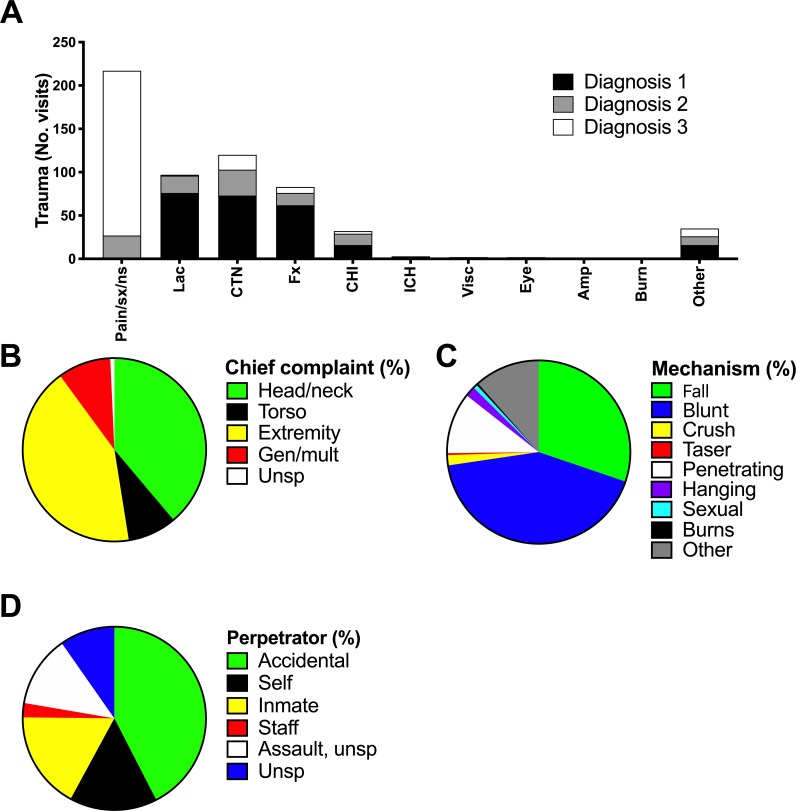
Incarcerated trauma patients present with a range of injuries and mechanisms.Primary, secondary, and tertiary discharge diagnoses (A), primary injury location (B), mechanism of injury (C), and reported perpetrator (D) for 278 trauma-related encounters of incarcerated patients presenting to a tertiary care, academic emergency department between January 2012 and December 2014 were calculated in absolute number (No. visits) or percent (%) of patient encounters as indicated. Amp, amputation; CTN, contusion; Fx, fracture; Gen, general; ICH, intracerebral hemorrhage; Lac, laceration; Multi, multi-organ; Unsp, unspecified; Visc, visceral injury.